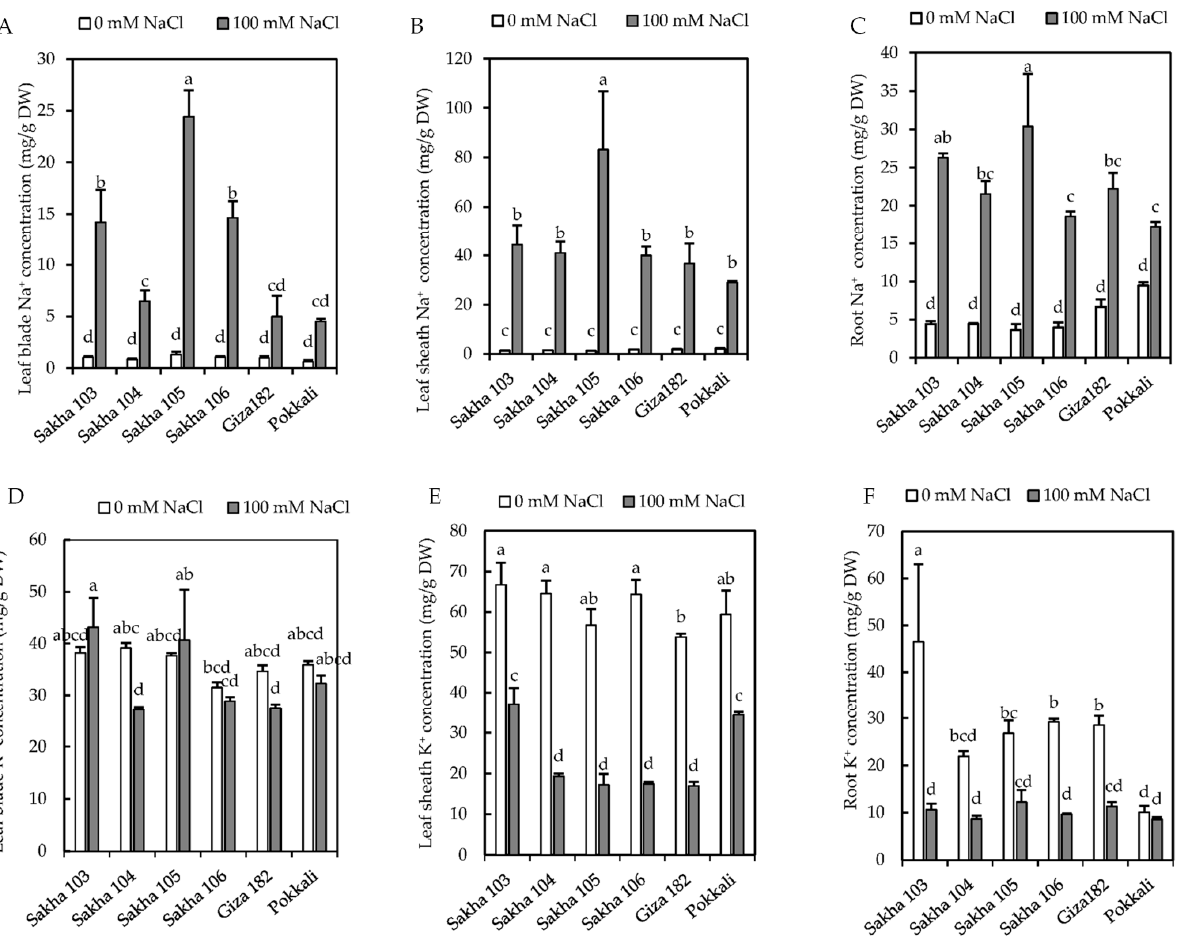
Figure 2. The Na + ( A–C ) and K + ( D–F ) concentrations increased in the leaf blades and sheaths and roots of Sakha 103–106, Giza 182, and Pokkali under control conditions and salinity stress at 14 days after treatment. The bars represent the means ± SE (standard errors) ( n = 4). The bars with same letter on the top are not significantly different ( p ≤ 0.05).